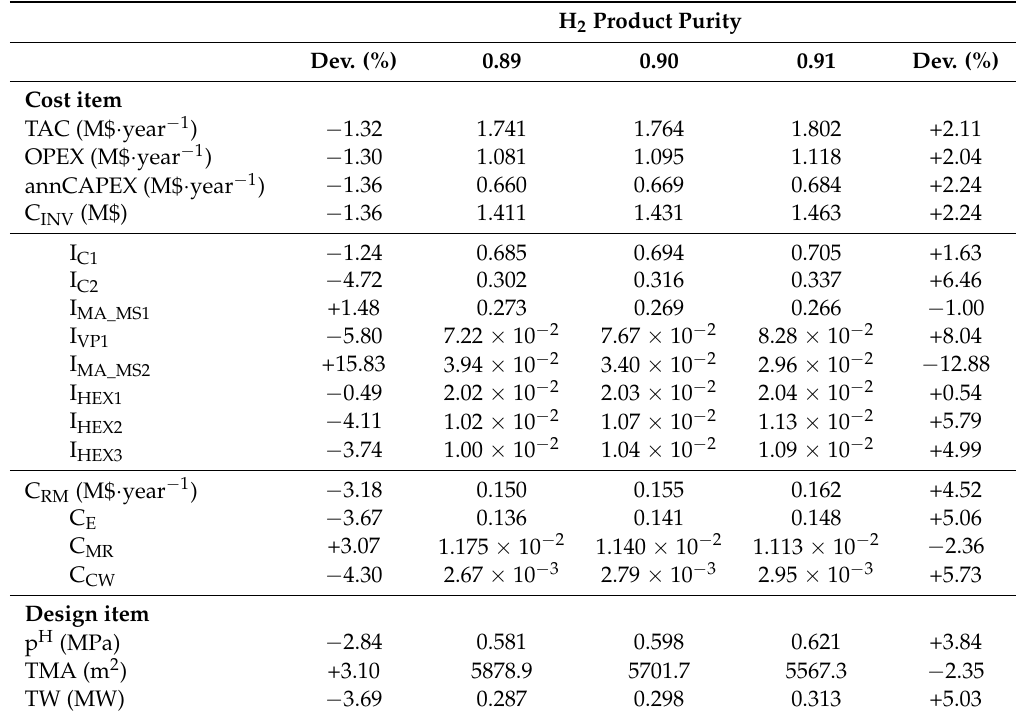
Table 3. Sensitivity of the optimal solution to the H 2 product purity for a H 2 recovery of 90% and H